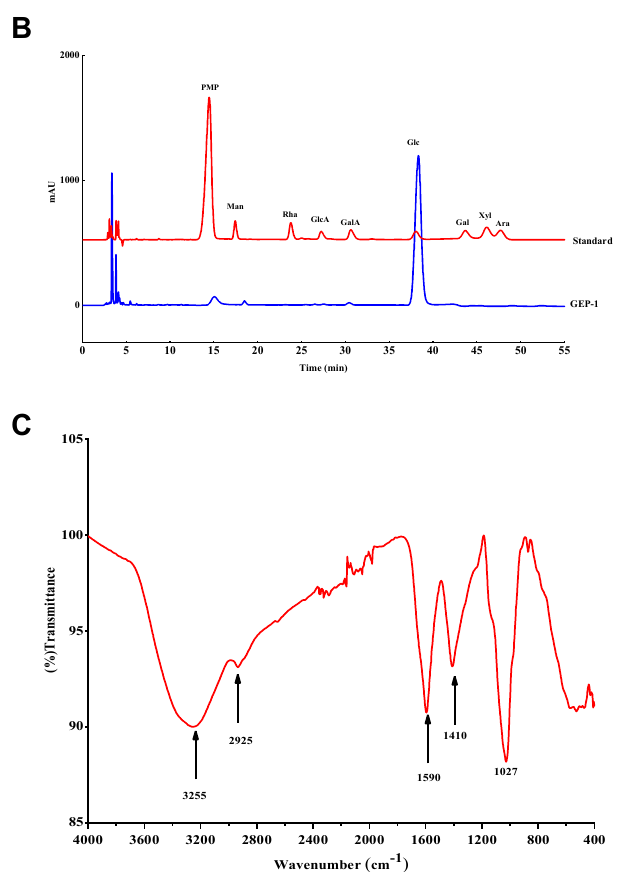
Figure 1. ( A ): HPGPC of GEP-1; ( B ): HPLC chromatograms of PMP derivatives; ( C ): FT-IR spectrum of GEP-1.